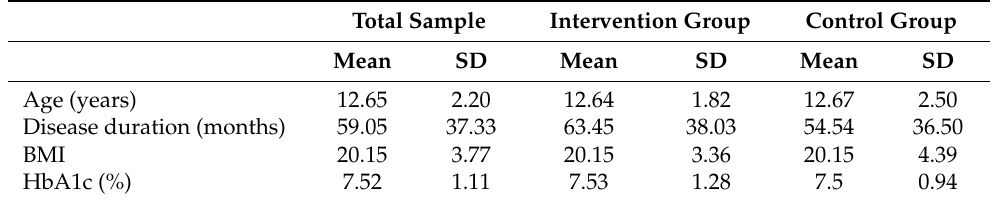
Table 2. Demographic and clinical characteristics of the study population (Mean and Standard